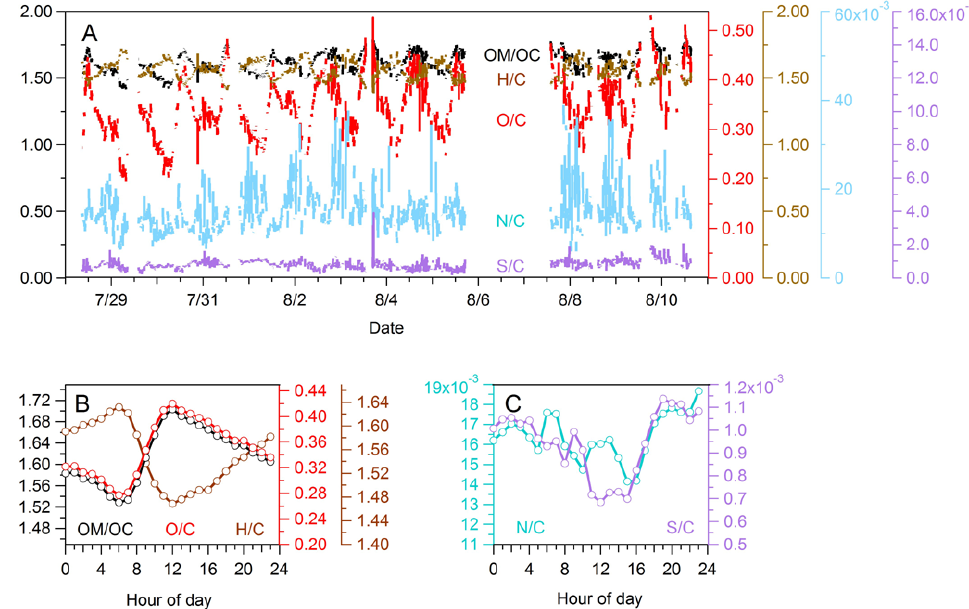
Fig. 5. Elemental analysis (EA) results for SOAR-1 OA. Time series and diurnal profiles of elemental ratios and organic mass to organic carbon (OM/OC) ratio are shown in panel a. Panel b shows diurnal profiles of OM/OC, O/C, and H/C while panel C shows diurnal profiles of N/C and S/C